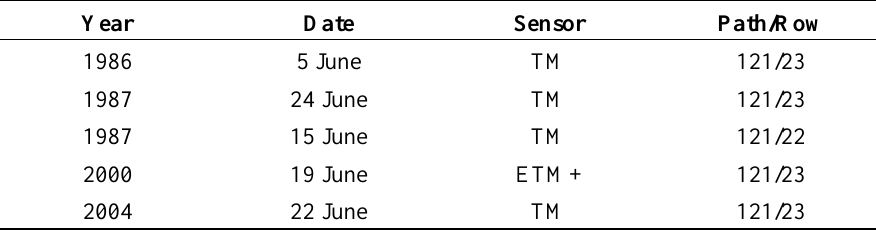
Table 1. Landsat TM and ETM+ scenes used in this